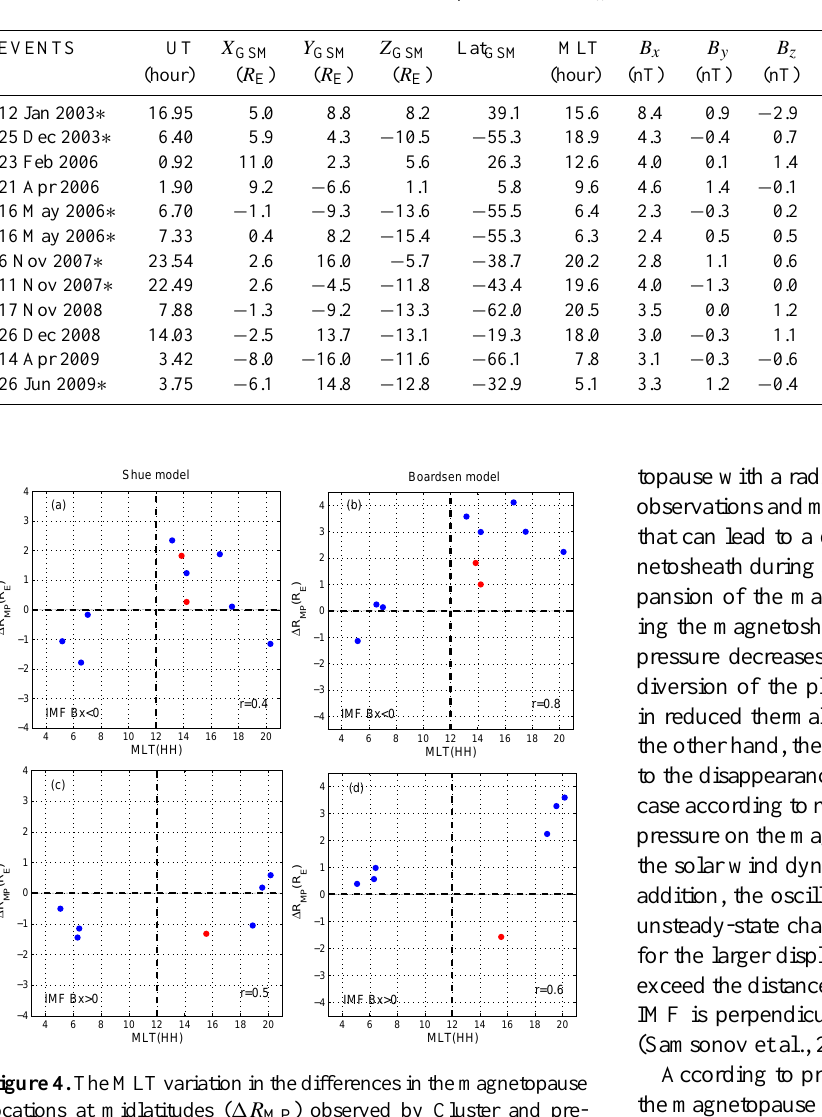
Table 2. Same as Table 1 but for the sunward RIMF periods (IMF B x > 0).